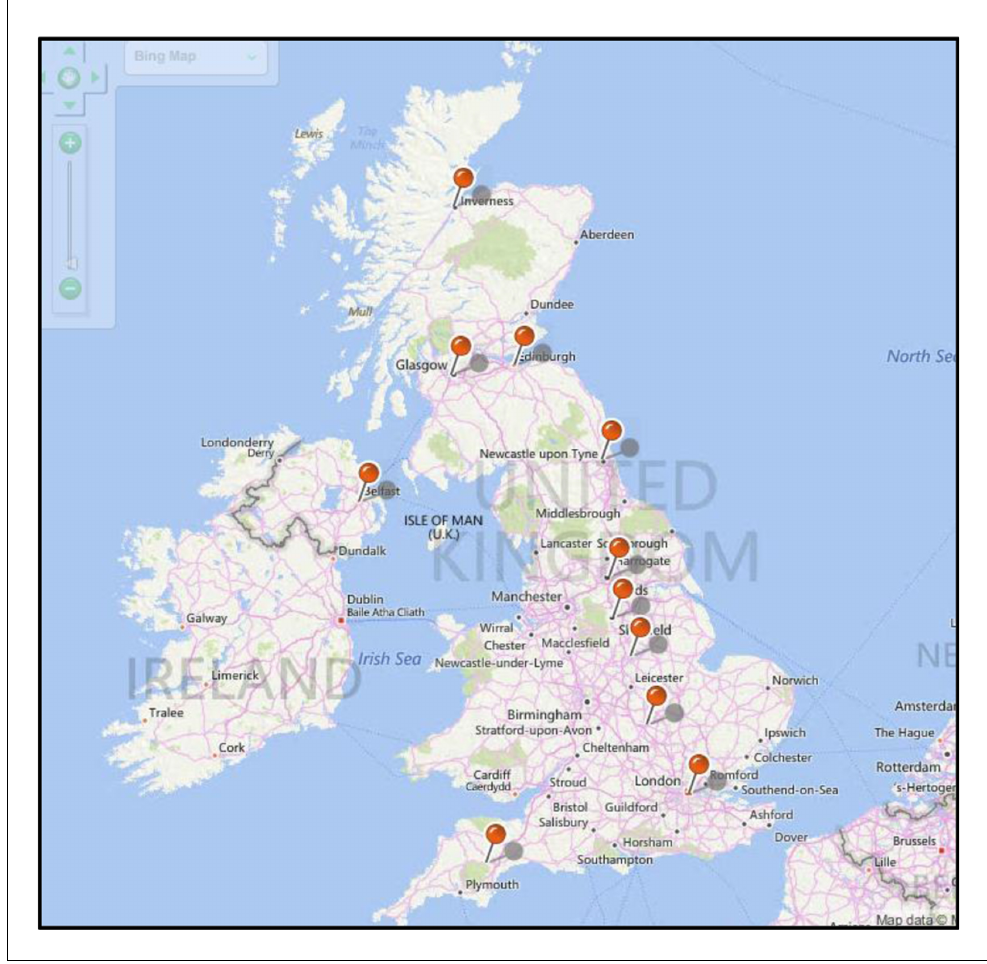
Figure 1. UK locations of specialist gender identity clinics.